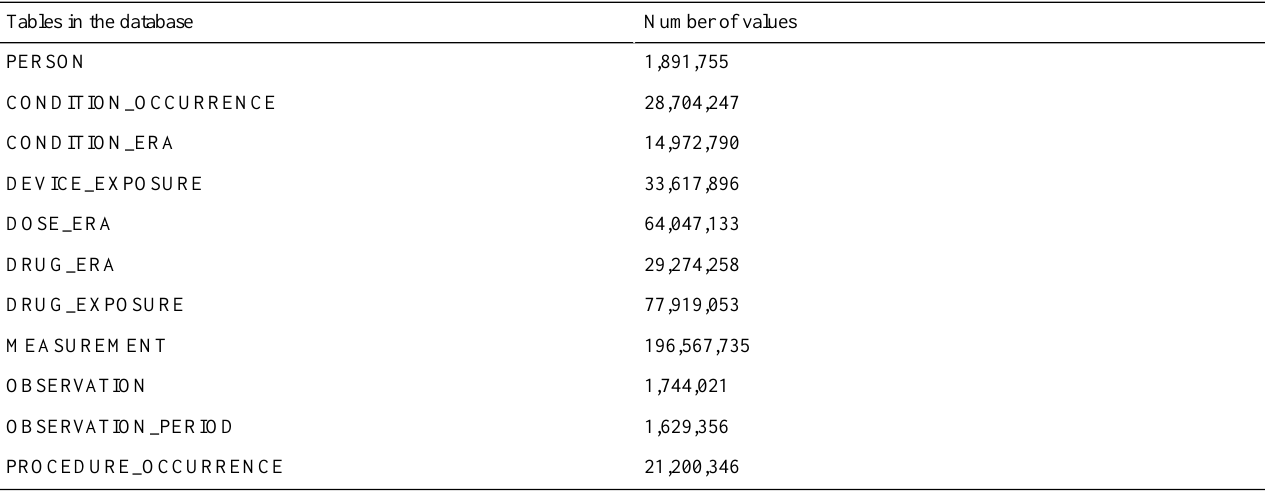
Table 2. Number of data values per table in the Korea University Anam Hospital Common Data Model (CDM) database.